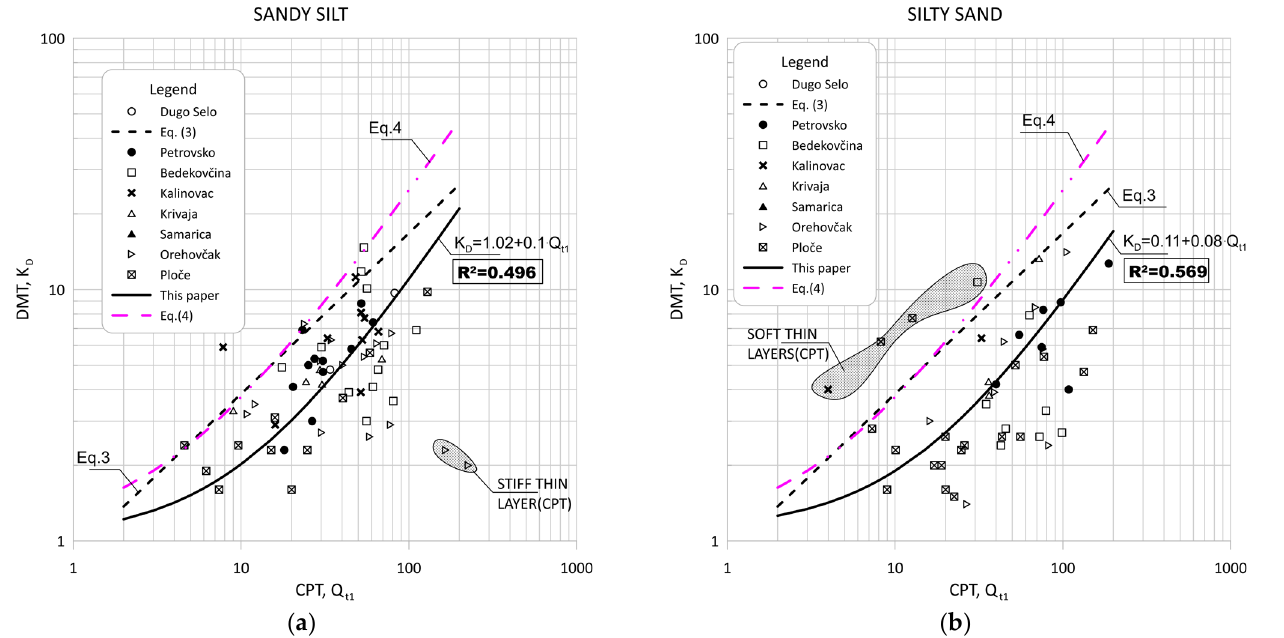
versus < 1.2, 2.05 < < 2.95). 𝑄𝑄 𝑡𝑡1 𝐾𝐾 𝐷𝐷 𝐼𝐼 𝐷𝐷 𝐼𝐼 𝑐𝑐